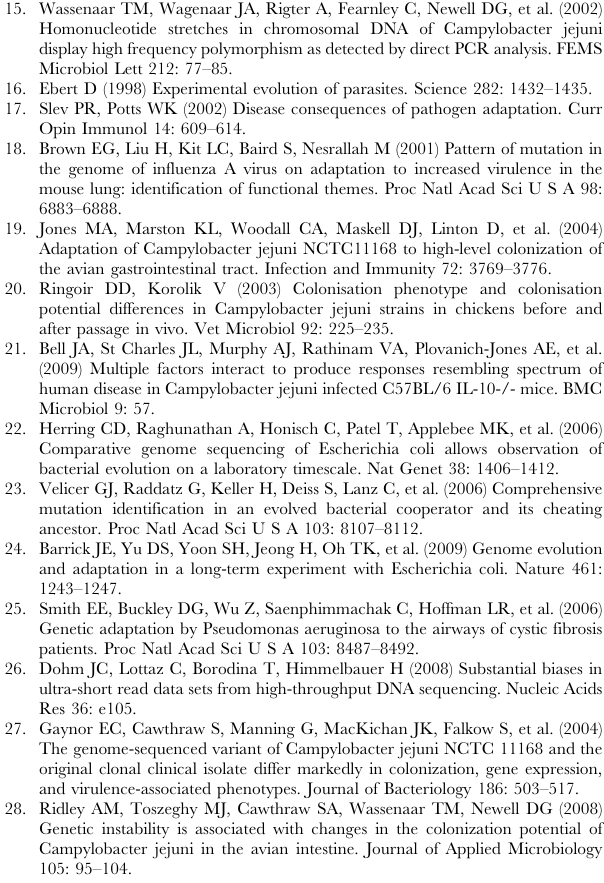
Figure S1 Estimated indel error rates. Representative graph of estimated error rates for different base substitution and indel mutations by quality score. This graph is from the re-sequencing data for wild-type when the reference base is adenine, but in all estimations, indel error rates fall below base substitution error rates.